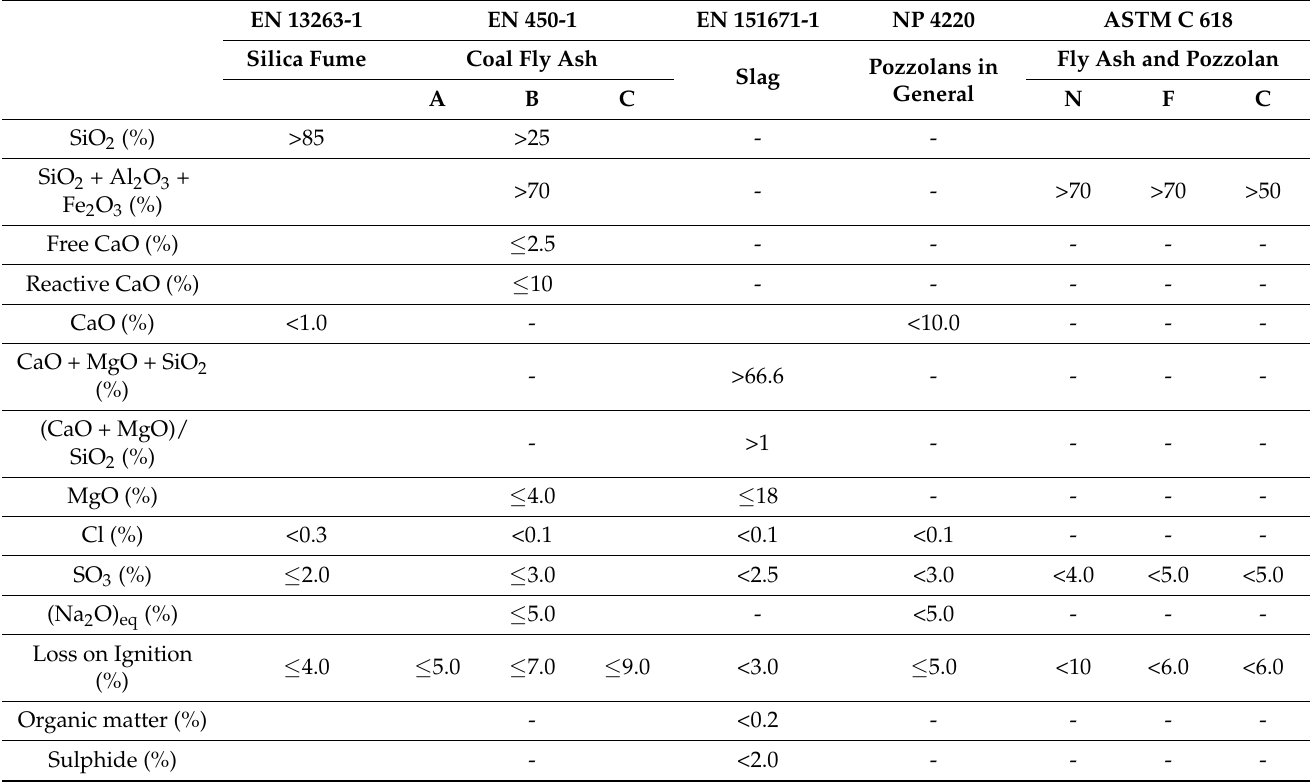
Table 1. Chemical, physical, and mechanical requirements for various SCM used in concrete. EN